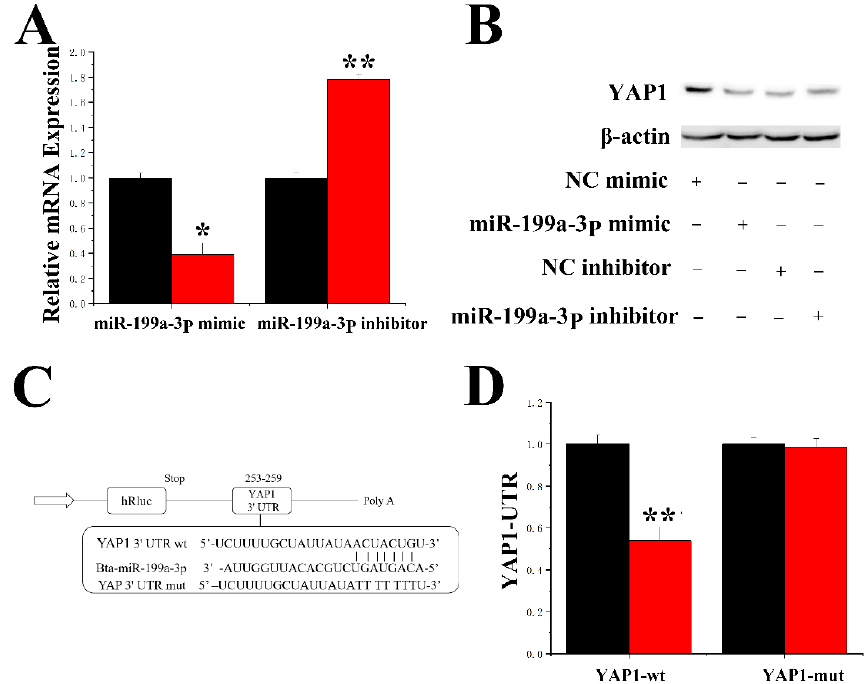
Figure 8. miR-199a-3p specifically targets YAP1 . ( A ) mRNA expression levels of YAP1 in response to the miR-199a-3p mimic and miR-199a-3p inhibitor. Black bars represent the negative control, and red bars represent the miR-199a-3p mimic or inhibitor. ( B ) Protein expression levels of YAP1 . ( C ) Target site of miR-199a-3p in the YAP1 3 ′ -UTR. ( D ) Construction of the luciferase (Luc) vector fused with the YAP1 3 ′ -UTR. WT: Luc reporter vector with the WT YAP1 3 ′ -UTR (253 to 259); MU: Luc reporter vector with a mutation at the miR-199a-3p site in the YAP1 3 ′ -UTR. Values are presented as the means ± standard errors. * p < 0.05; ** p < 0.01.